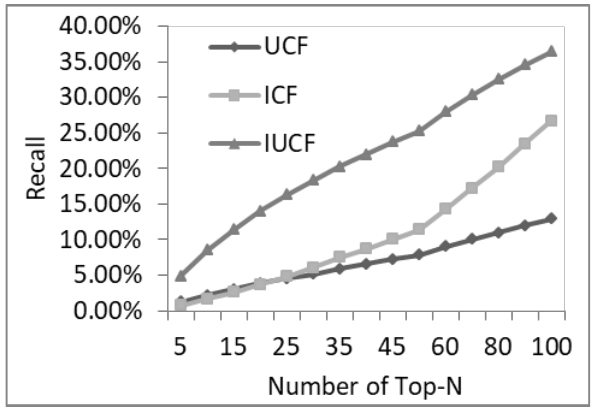
Figure 7. Comparison of recall with Top- N changes.